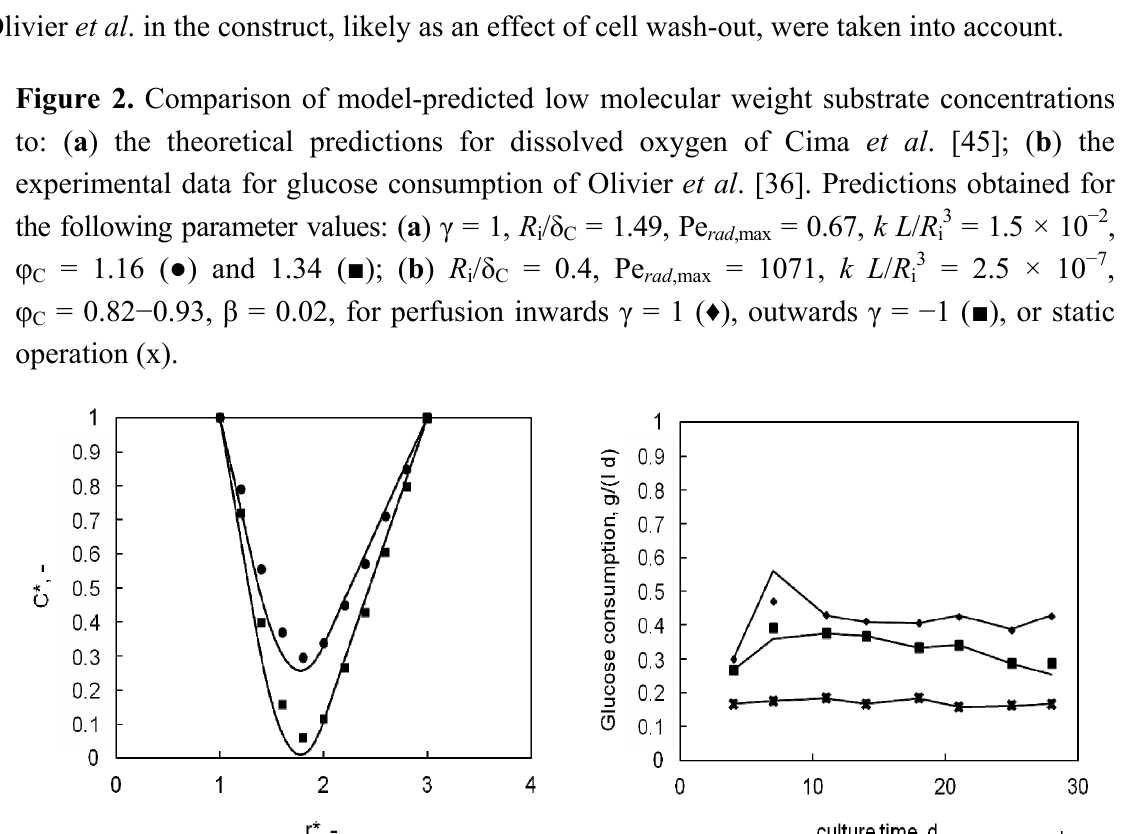
Figure 2. Comparison of model-predicted low molecular weight substrate concentrations to: ( a ) the theoretical predictions for dissolved oxygen of Cima et al . [45]; ( b ) the experimental data for glucose consumption of Olivier et al . [36]. Predictions obtained for the following parameter values: ( a ) γ = 1, R